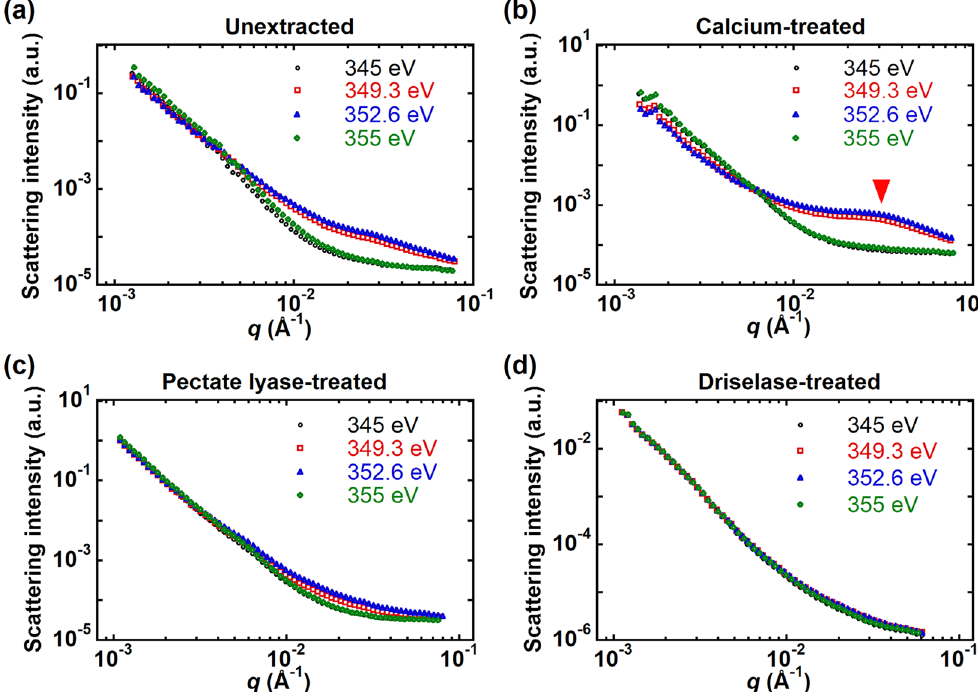
Figure 5. RSoXS profiles at resonance (349.3 eV and 352.6 eV) and off resonance (345 eV and 355 eV) near the calcium L-edge of ( a ) unextracted, ( b ) calcium-treated, ( c ) pectate lyase-treated, and ( d )